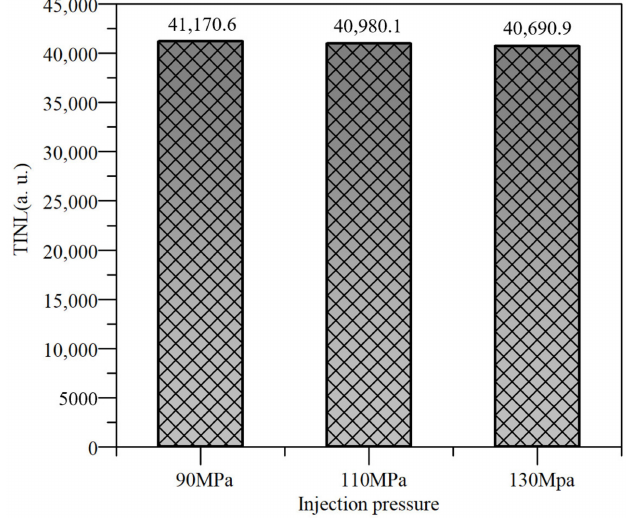
Figure 16. The flame time integral natural luminosity